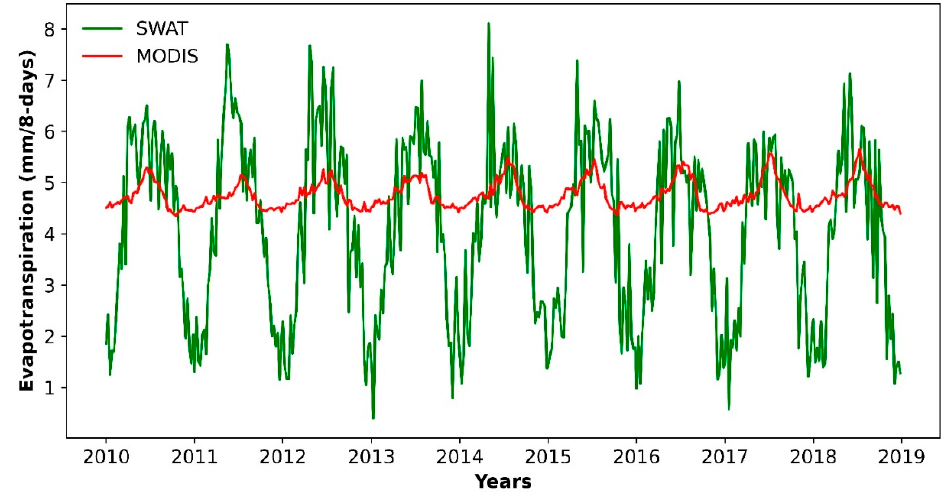
Figure 6. Comparison of 8-day SWAT-simulated vs. MODIS evapotranspiration data.